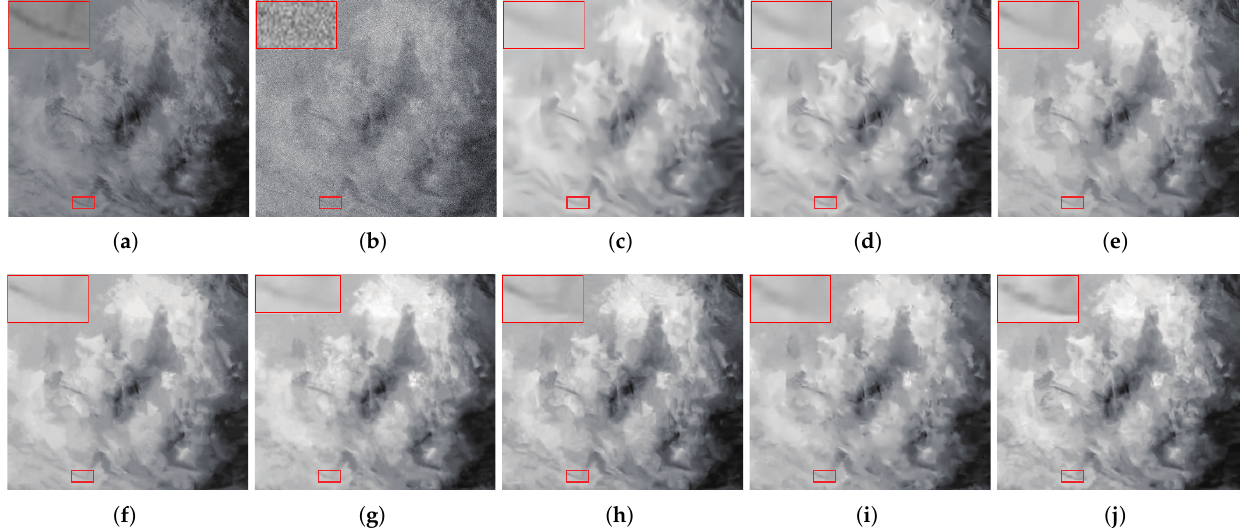
Figure 7. Visual comparison of experiments on the MODIS-T2 image. ( a ) Ground-truth. ( b ) Noised